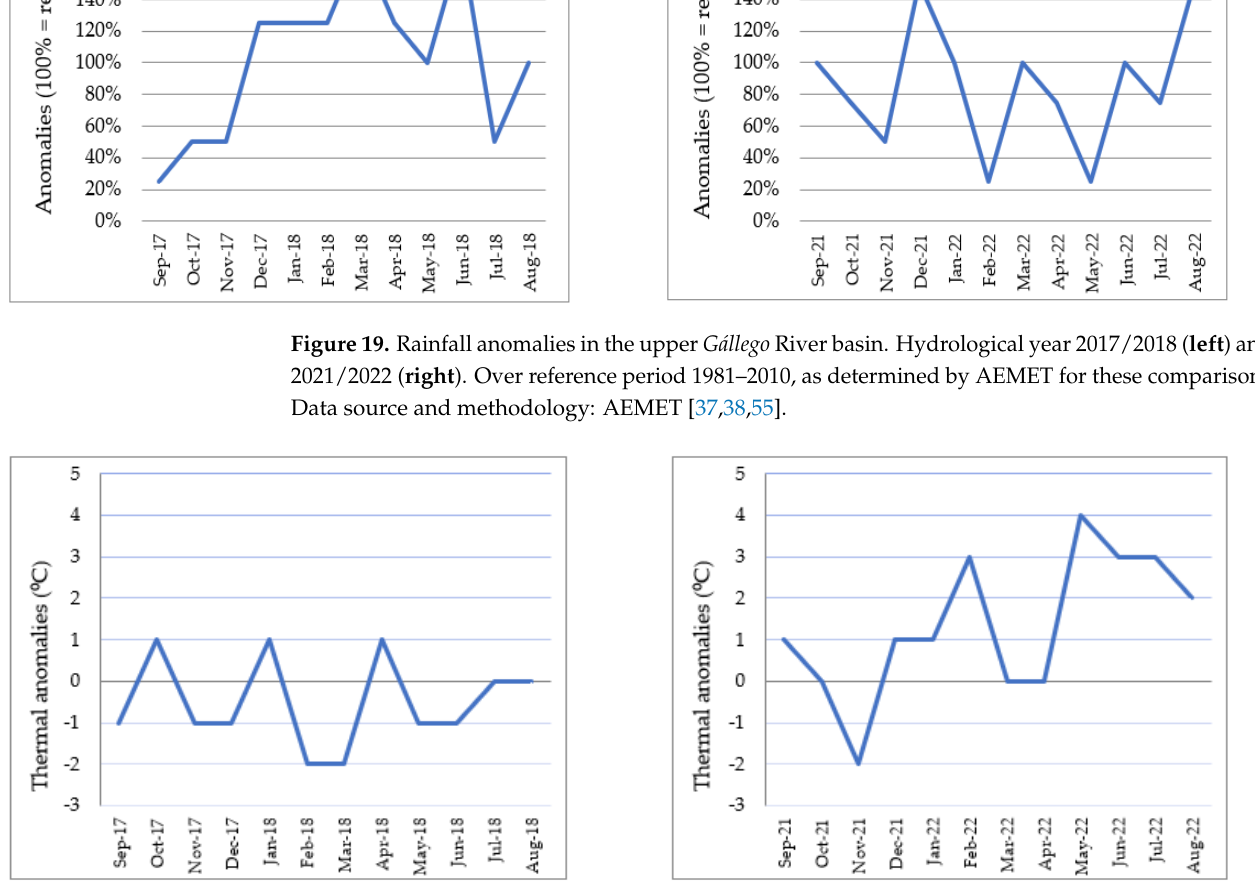
Figure 20. Thermal anomalies in the upper Gállego River basin. Hydrological year 2017/2018 ( left ) and 2021/2022 ( right ). Over reference period 1981 – 2010, as determined by AEMET for these com- parisons. Data source and methodology: AEMET [37,38,57,58].